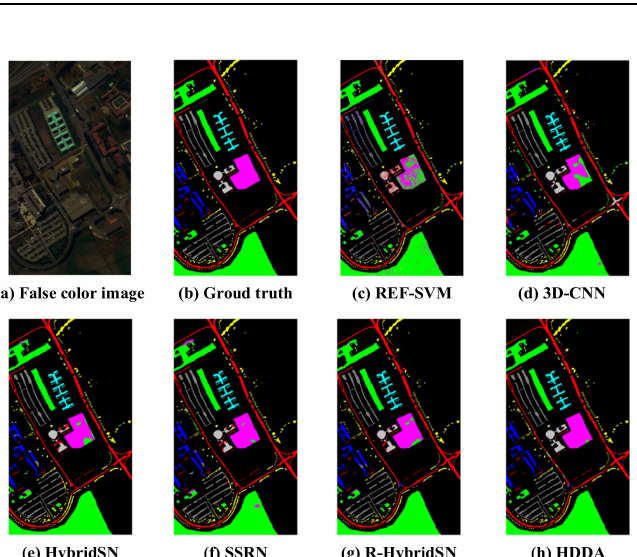
Figure 13. Classification maps using only the training samples (1% of total samples) for the PU dataset. ( a ) False color image; ( b ) Ground truth; ( c ) REF-SVM; ( d ) 3D-CNN; ( e ) HybridSN; ( f ) SSRN; ( g ) R-HybridSN; ( h )